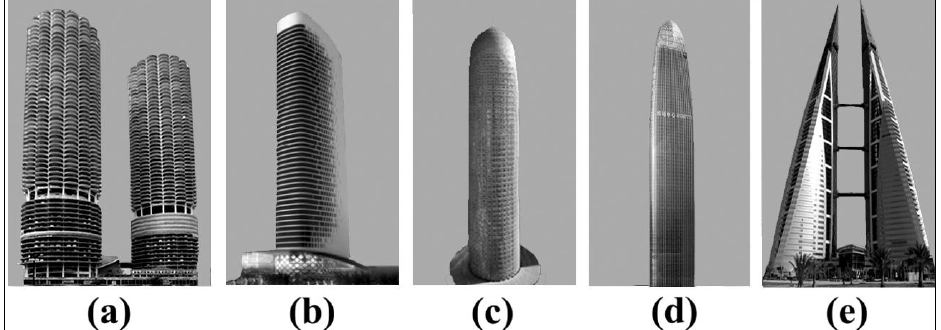
Figure 1. Extruder type of high-rise buildings: ( a ) Marina City towers (Chicago, cylindrical central core system), ( b ) Bay Gate (Dubai, wall frame system), ( c ) Doha tower (Doha, tube frame system), ( d ) Greenland Puli Center (Jinan, core and outrigger system) and ( e ) the World Trade Center (Bahrain, shear wall frame system), figure by authors.